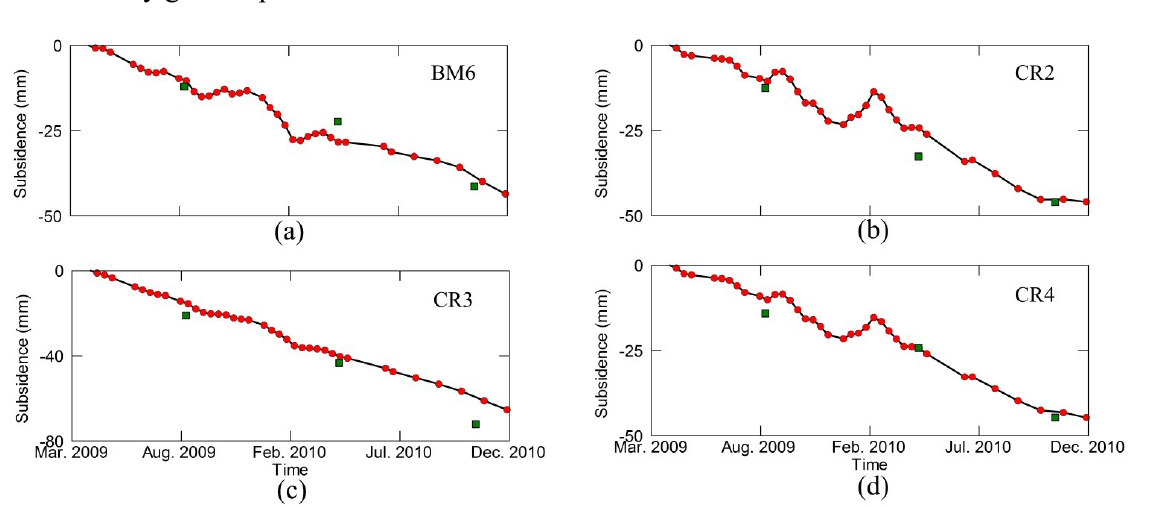
Figure 9. Time series of subsidence values (by red dots) derived from the MTInSAR solution at BM6, CR2, CR3 and CR4 ( a – d ). The subsidence values obtained by leveling are indicated by green